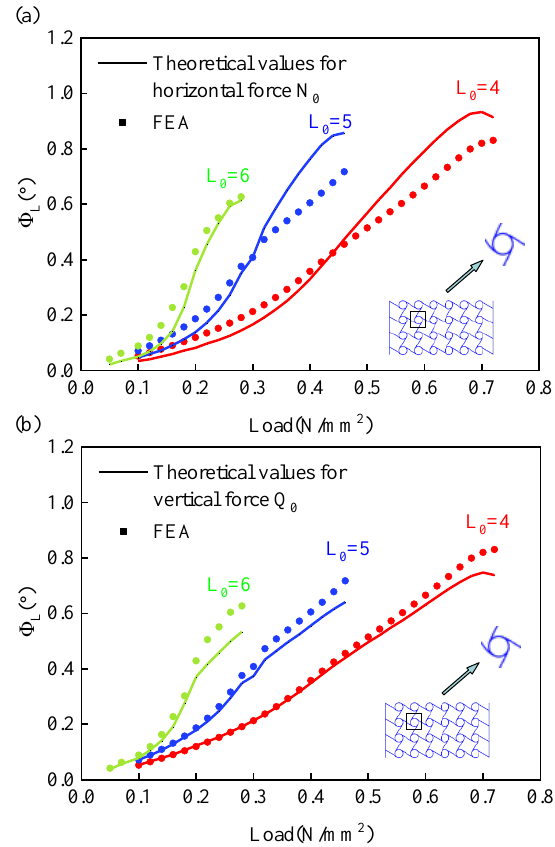
Figure 3. Curves of the rotation angle and load at node ‘A’ for different ligament beam lengths. ( a ) Rotation angle-load relationship curve under the action of horizontal force; ( b ) Rotation angle-load relationship curve under the action of verticalforce.